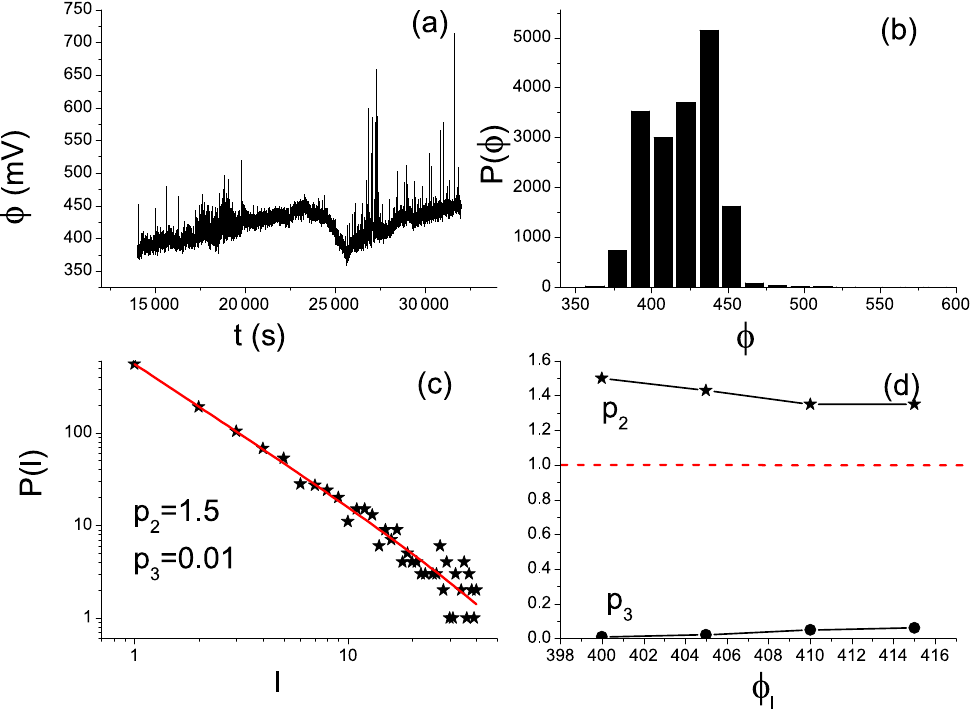
Figure 5. (a) The 18000-sample long critical window of the MHz EME that was recorded before the Cephalonia M w = 5 . 9 EQ at the Zante station; (b) , (c) , and (d) are similar to the corresponding parts of Fig. 2. In (c) , the distribution of laminar lengths corresponds to the end point φ l =